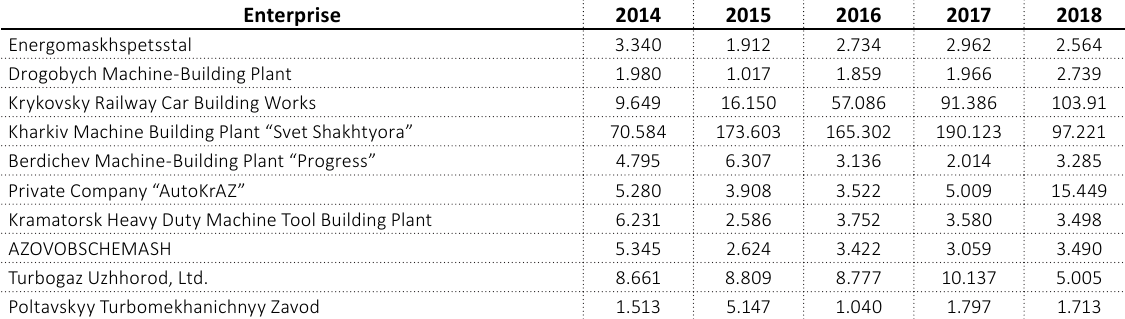
Table B1. The distance between indicators and reference vector of machine-building enterprises of